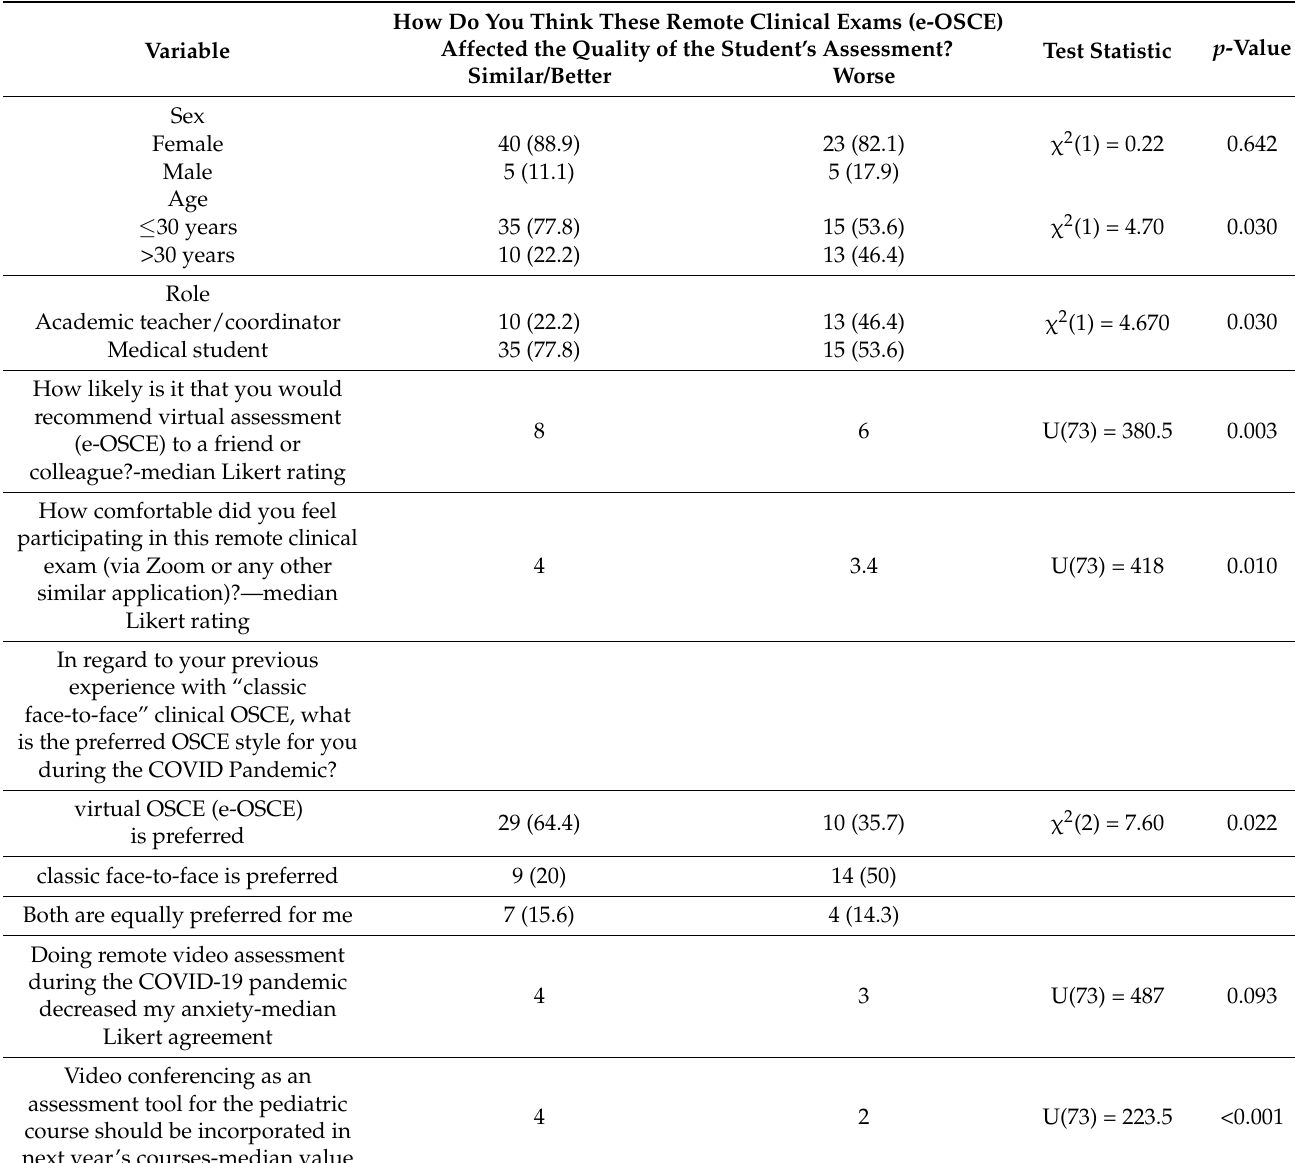
Table 4. Bivariate analysis of participants’ e-OSCE quality of